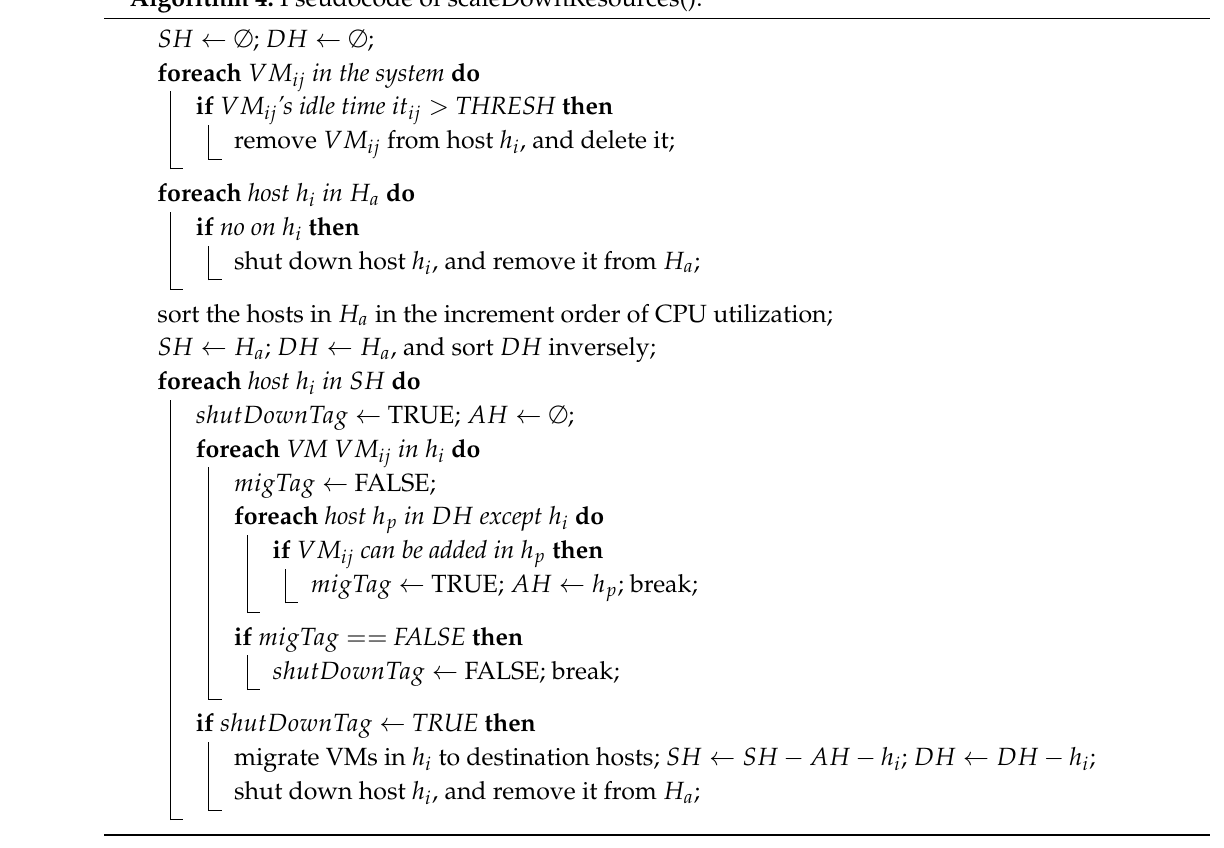
Algorithm 4: Pseudocode of